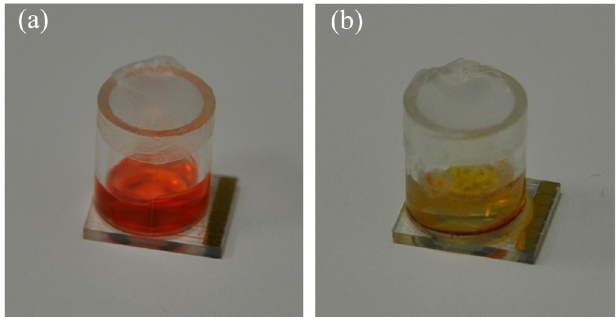
Figure 10. Culture medium prepared using methyl red as a reference indicator dye: ( a ) initial orange color of the medium in the cavity where pH is 5.5; ( b ) medium turned yellow due to increase in pH to 6.5 with the growth of Eurotium mold. The glass cavity has an internal diameter of 7 mm.